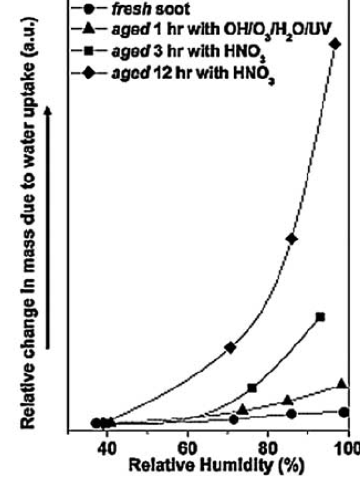
Figure 6. Water uptake (quantified as the ratio of mass of water taken up to the dry particle mass) of fresh and aged soot particles. Reprinted with permission by Zuberi et al. (2005). Copyright 2005 John Wiley & Sons,